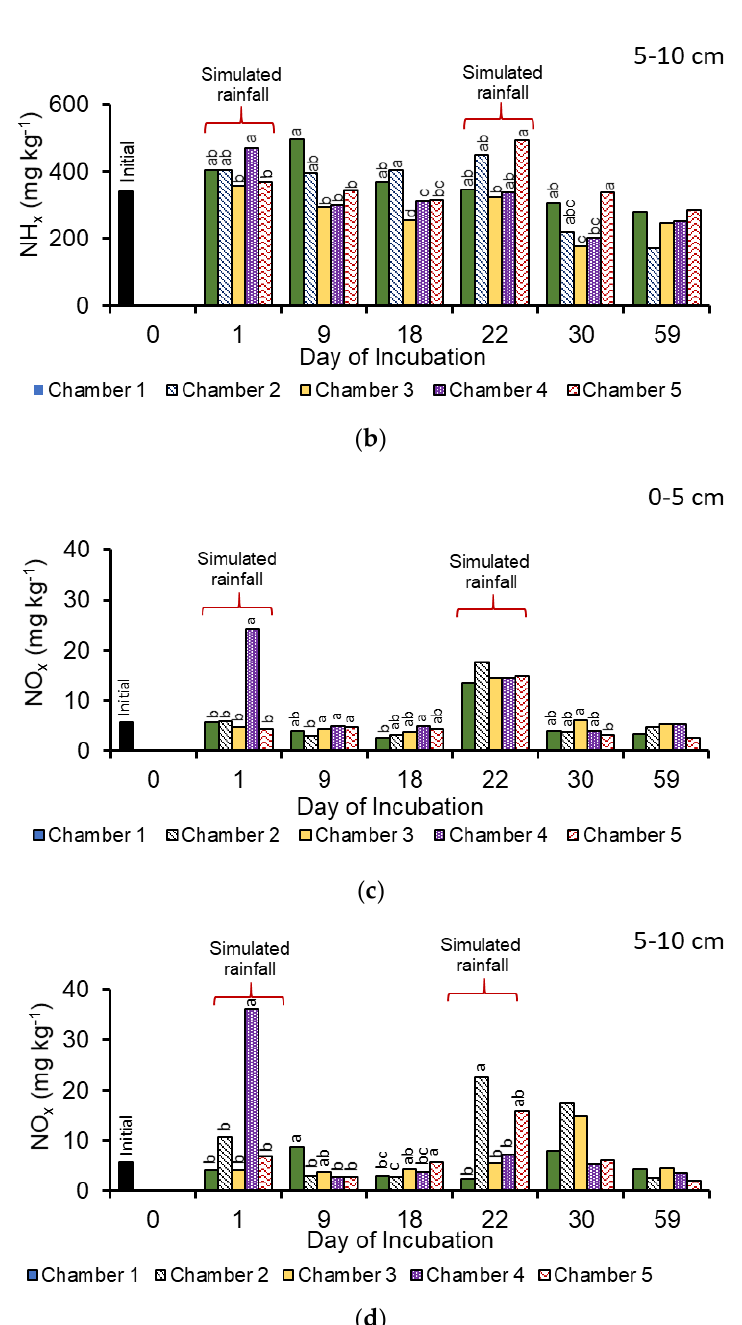
Figure 7. Concentrations of ammonia / ammonium (NH x ) and nitrate / nitrite (NO x ) during the study period in the five chambers at 0 – 5 cm and 5 – 10 cm depths. Columns with different superscript letters on each day were significantly different at p < 0.05. ( a ) NH x at 0 – 5 cm, ( b ) NH x at 5 – 10 cm, ( c ) NO x at 0 – 5 cm, ( d ) NO x at 5 – 10 cm.